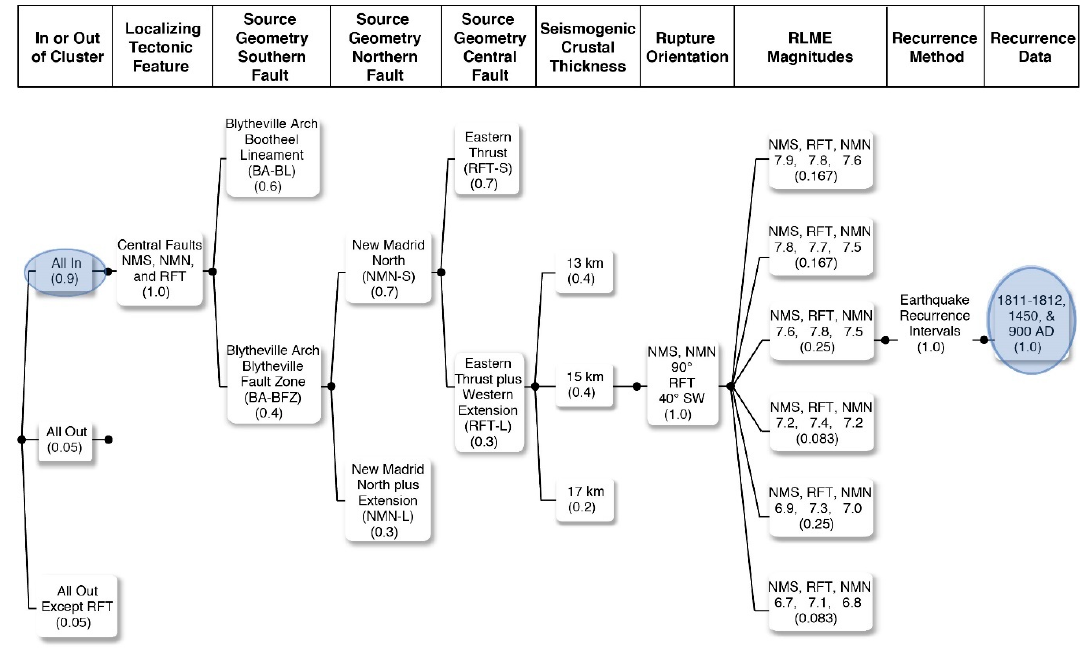
Figure 32. NMSZ logic tree of seismic source model in CEUS SSC Project (modified from Reference [35]). Paleoliquefaction data are reflected in weighting of clustered behavior and in recurrence data used in seismic source model.